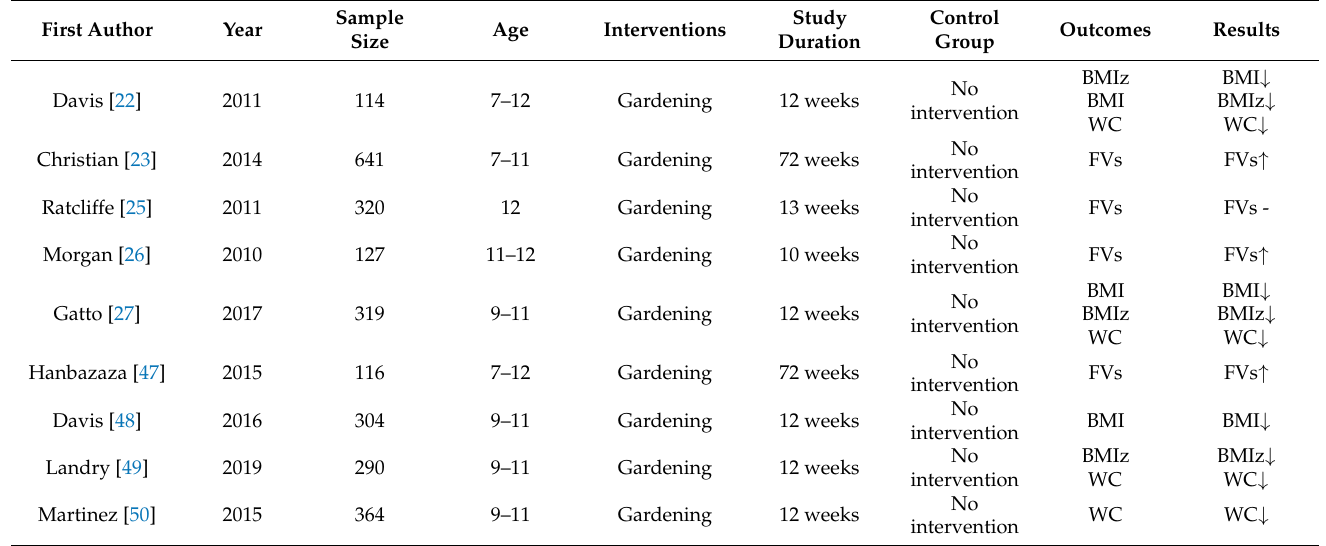
Figure 1. Flow diagram of studies selection. *Consider, if feasible to do so, reporting the number of records identified from each database or register searched (rather than the total number across all databases/registers). Table 1. Characteristics of the included